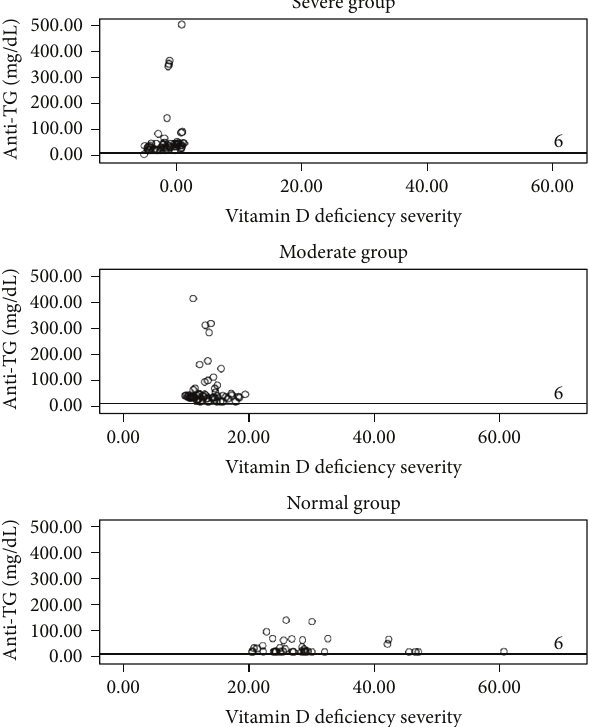
Figure 1: The correlation between TSH and vitamin D in each group.